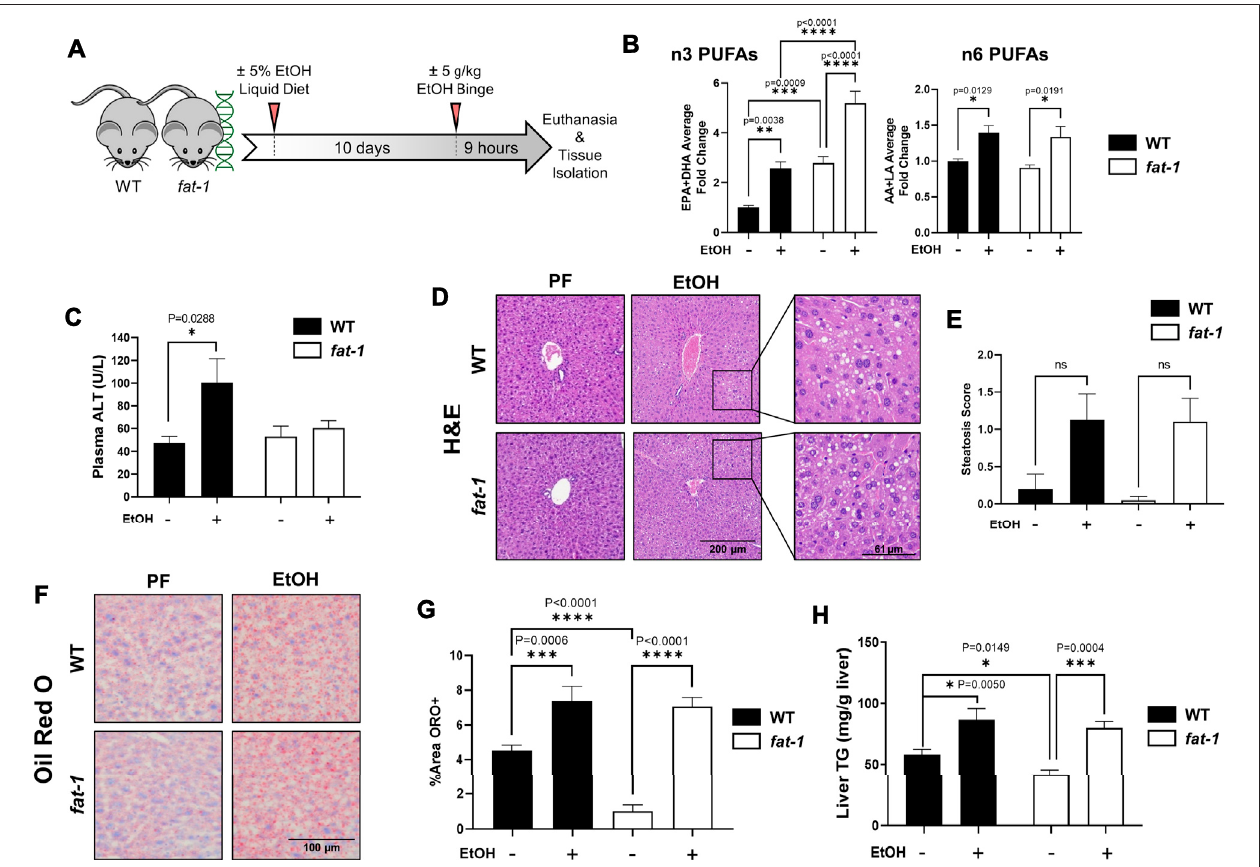
FIGURE1 | Characterizationof liver pathology inWT and fat-1 mice in anacute-on-chronic mouse model ofALD. (A) Experimental design, (B) liver n3-PUFA (EPA and DHA) and n6-PUFA (AA and LA) levels, (C) plasma ALT, (D) H&E staining, (E) quantitation of liver steatosis, (F) Oil Red O staining, (G) quantitation of Oil Red O staining, and (H) total liver triglycerides.. All images are 200X magni fi cation. * p < 0.05, ** p < 0.01, *** p < 0.001, **** p < 0.0001, one-way ANOVA (comparisons not signi fi cant if unlabeled). WT PF ( n (cid:1) 14), fat-1 PF ( n (cid:1) 9), WT EtOH ( n (cid:1) 8), fat-1 EtOH ( n (cid:1) 10).